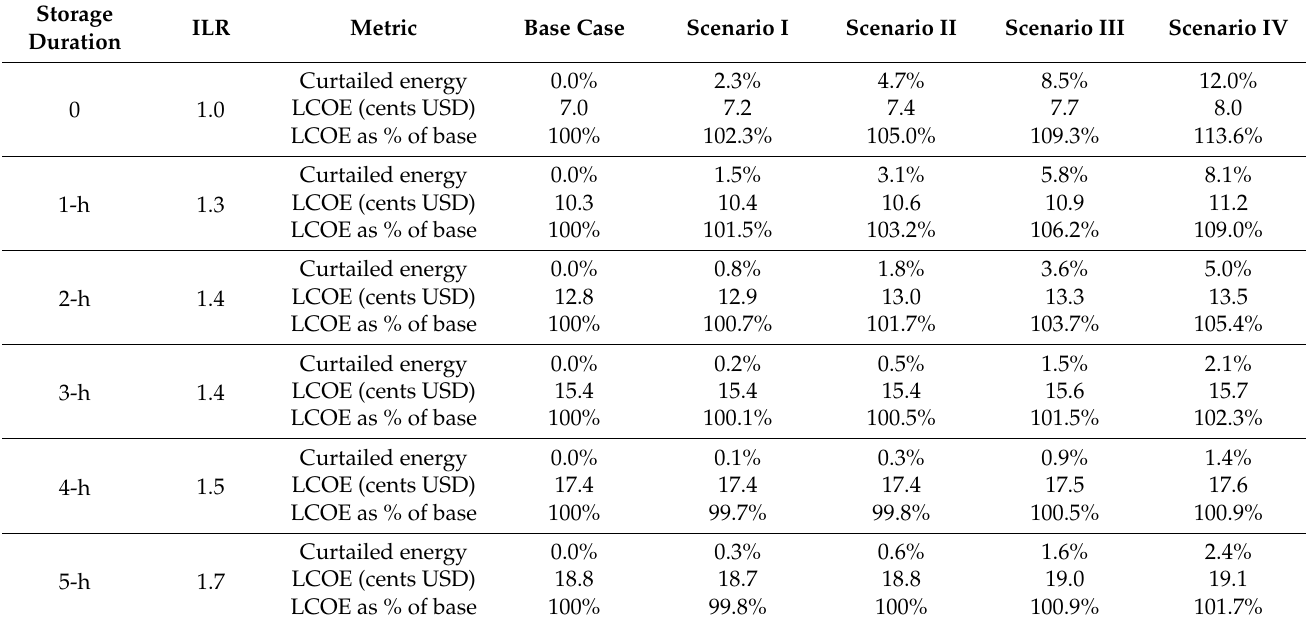
Table 9. Impact of curtailment on LCOE for single-axis PV plus battery